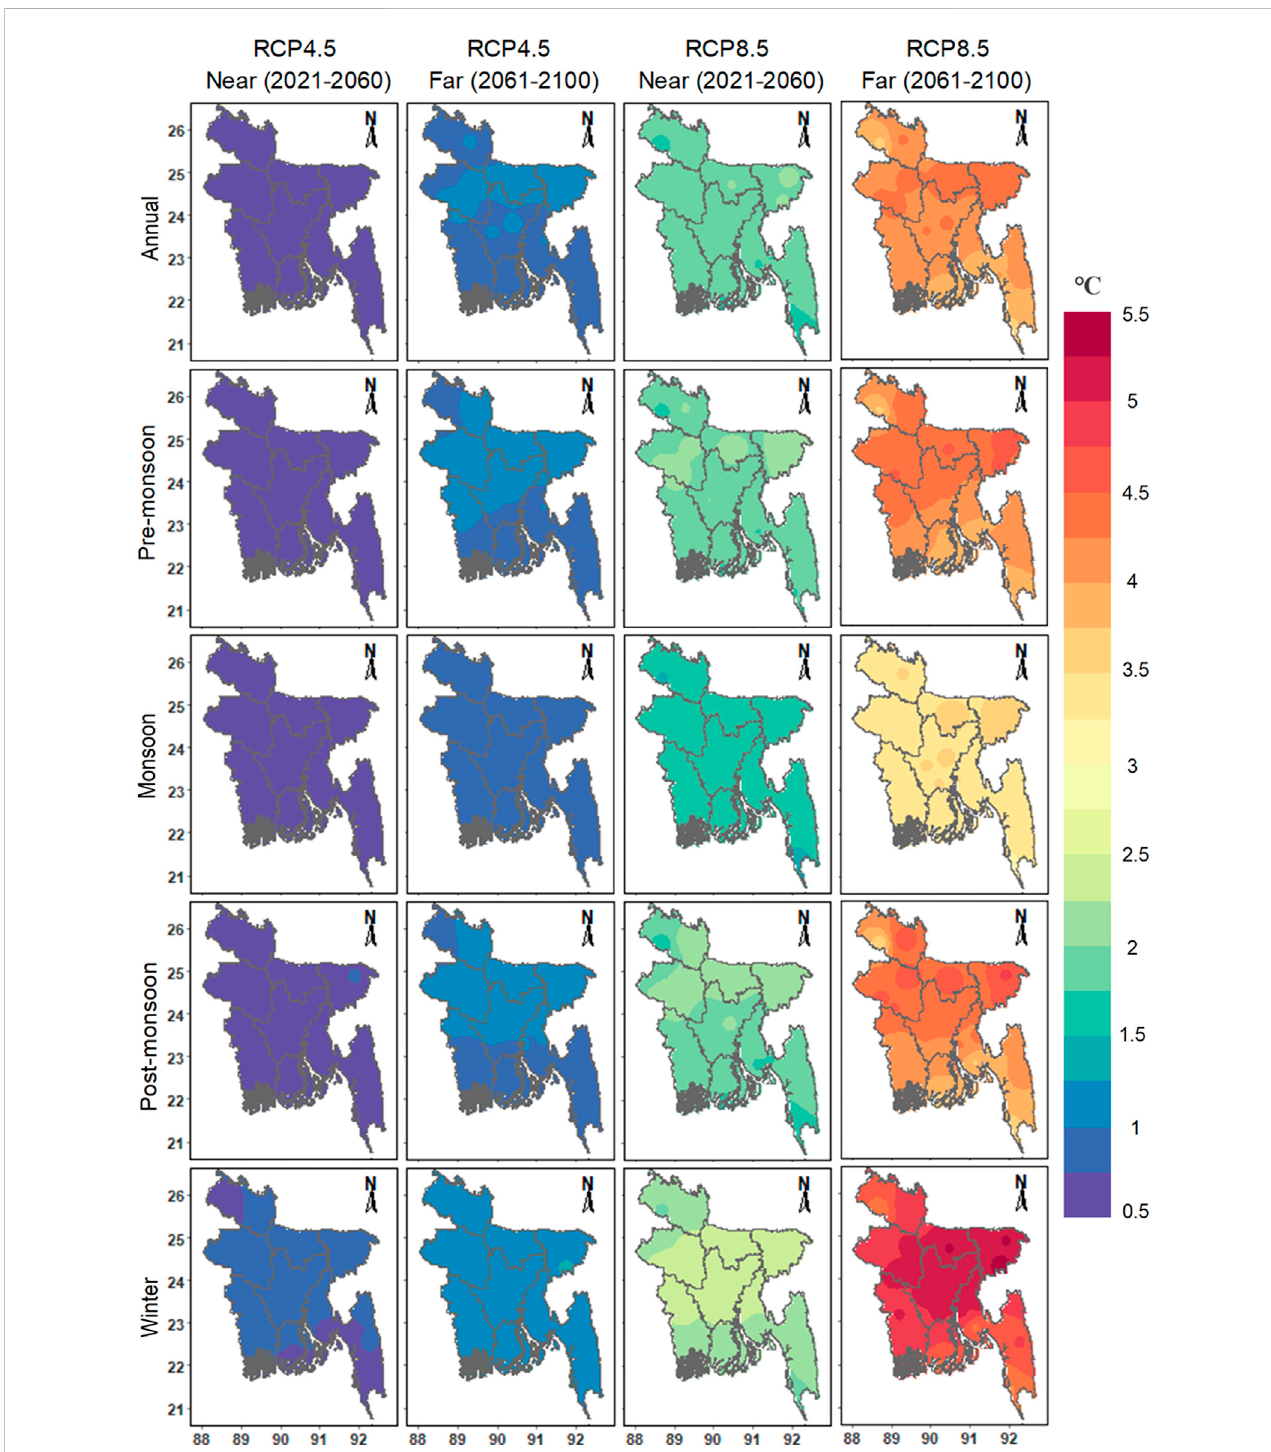
FIGURE 14 Spatial distribution of projected change in annual and seasonal Tmin ( ° C) for near (2021 – 2060) and far (2061 – 2100) future periods in Bangladesh for